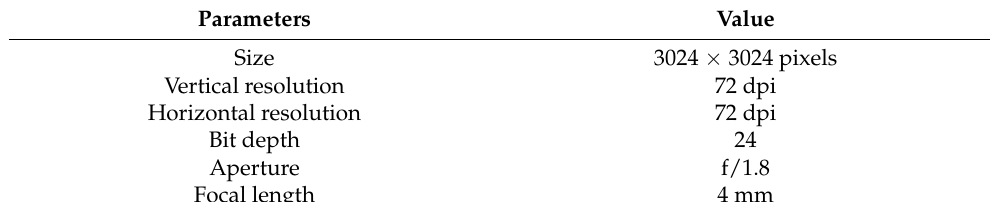
Table 1. Smartphone camera specifications.